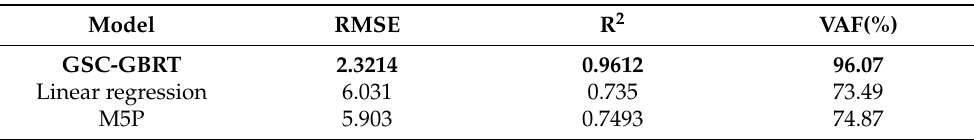
Table 5. GSC-GBRT, linear regression, and M5P models’ performance in predicting Cs for training and test datasets.